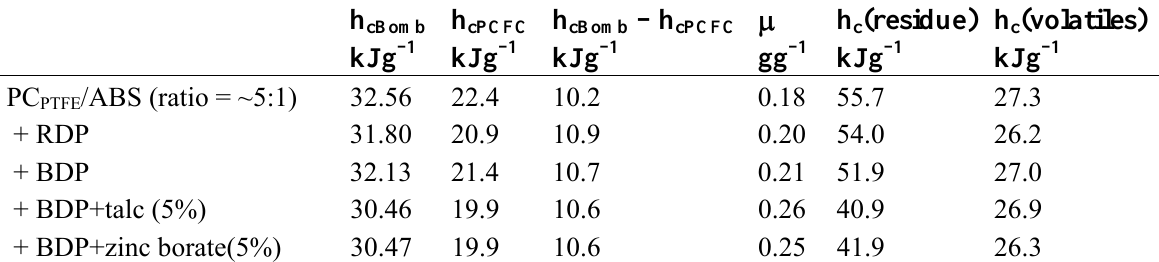
Table 4. Comparison between h from bomb calorimeter. h measured in the PCFC; RDP = resorcinol bis(diphenyl